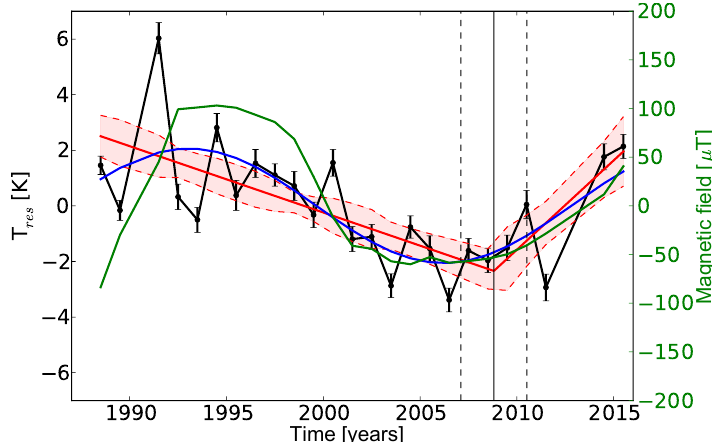
Figure 8. Residual for the temperature time series after removing the 11-year solar cycle ( C solar = (3.3 ± 0.9)K ( 100SFU ) − 1 ) and subtract- ing the mean. The black error bars show the uncertainties σ T . The red lines show the fit according to Eq. (7) and the blue curve the fit 0 according to Eq. (8). The reddish area defined by the red dashed lines shows the 1 σ uncertainty σ fit of the complete fit according to Eq. (7). The break point BP is marked by the vertical black line and the corresponding uncertainties are shown as vertical dashed black lines. Addi- tionally, the annual average values of the solar polar magnetic field strength are displayed as a green curve with a second axis to the right. Shown are the average values for the solar North Pole and South Pole with the magnetic field orientation of the North Pole ((N–S) / 2). The data were provided by the Wilcox Solar Observatory (for an instrument description see Scherrer et al., 1977).